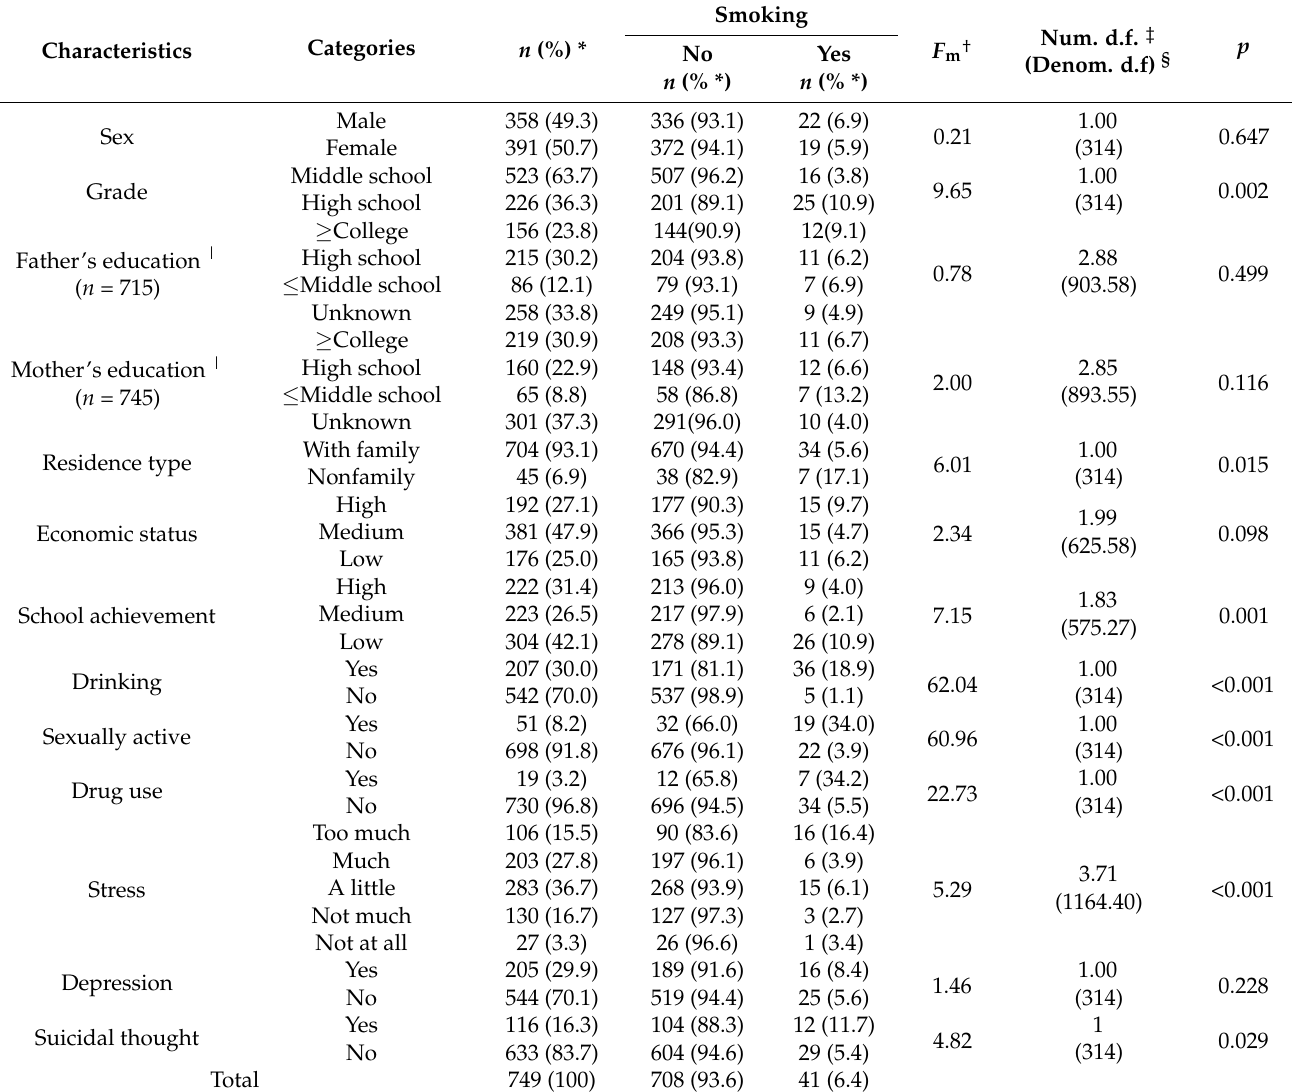
Table 1. Differences in smoking according to multicultural adolescents’ general characteristics, health risk behaviors, and mental health ( N =